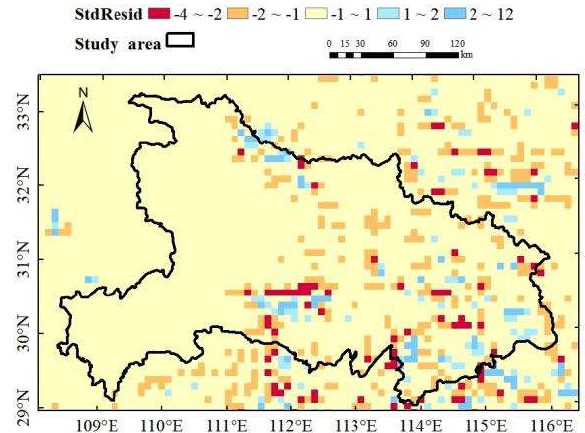
Figure 5. The GWR model’s StdResid values in December, 2016.